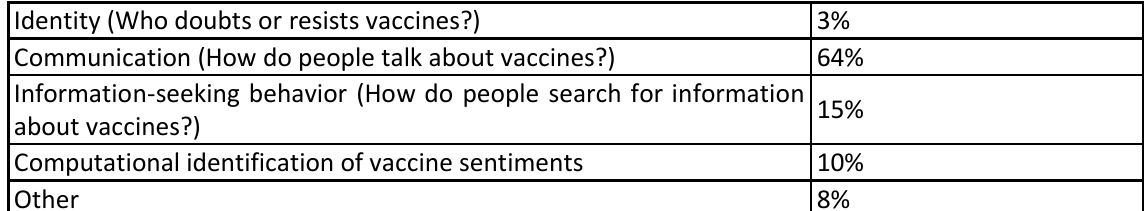
Table 2. Research focus (n = 100).